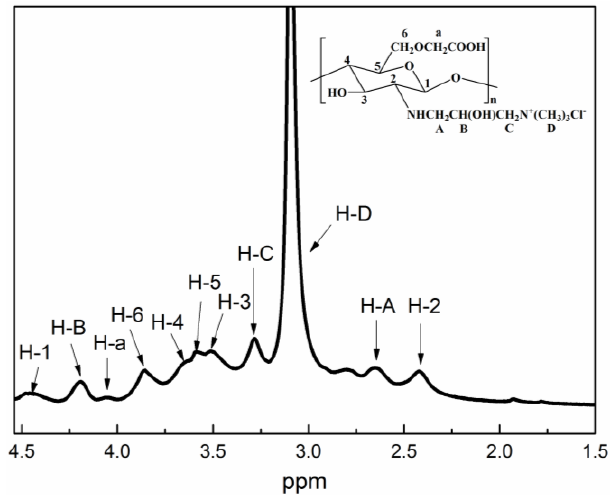
Figure 3. 1 H nuclear magnetic resonance (NMR) spectrum of QCMC.